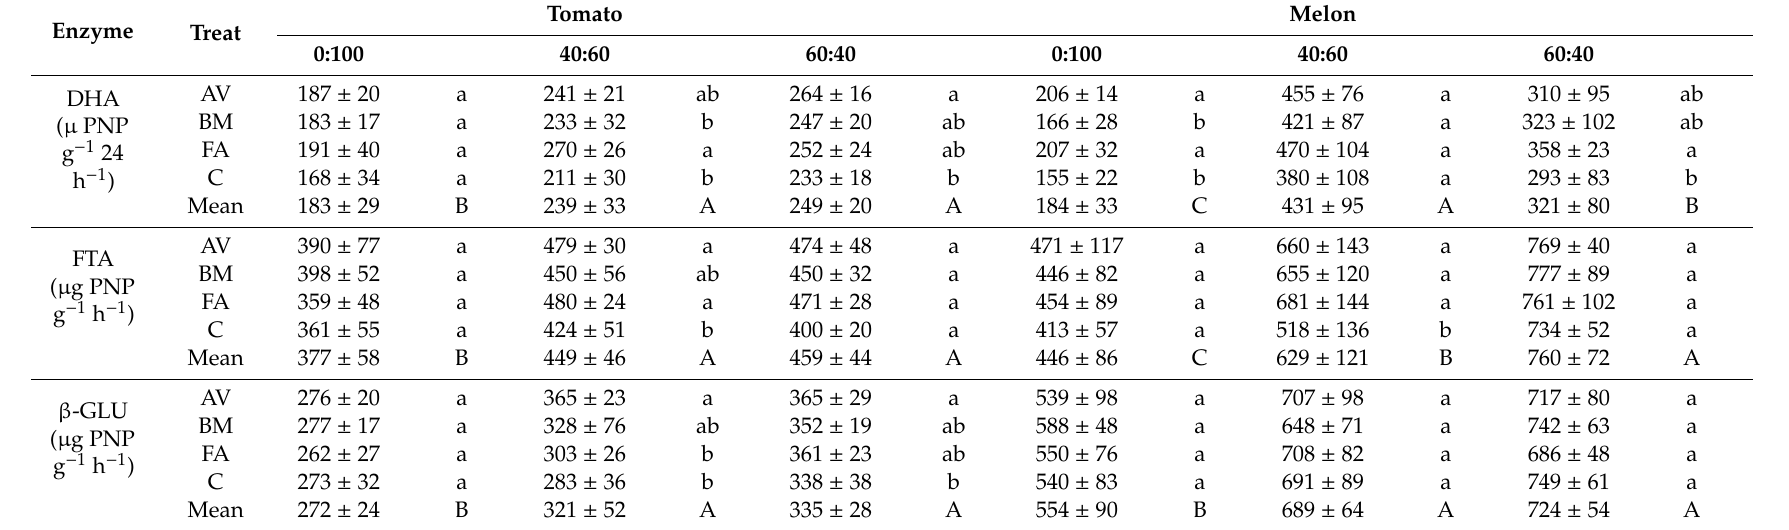
Table 5. Mean values of enzymatic activity analysed by treatment and